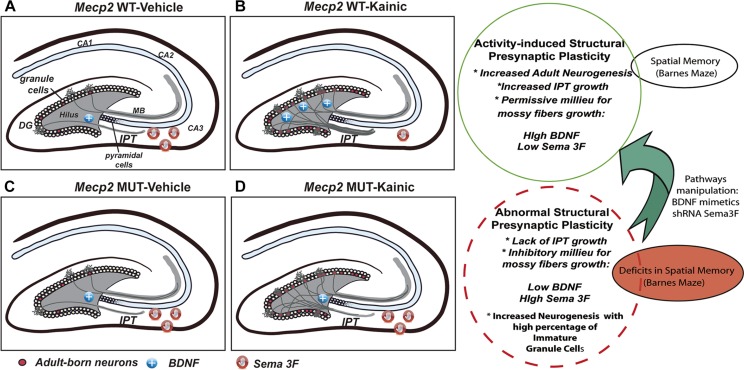
Schematic summary of the activity-induced presynaptic plasticity regulated by MeCP2. In WT mice, seizures activity increases the level of neurogenesis, accompanied with higher levels of BDNF and lower of Sema3F, allowing IPT to grow (A,B). Conversely, MUT animals show abnormal activity-dependent presynaptic plasticity characterized by the lack of IPT growth which correlates with imbalanced trophic and guidance support (BDNF and Sema3F abnormal levels). Although activity do increases the neurogenesis in MUT mice, adult born granule cells show developmental restraining and recapitulate maturational defects (C,D). These results are in line with deficits in spatial memory observed in MUT mice. This study set the basis to establish a model to evaluate the effect of manipulating specific pathways involved in axonal guidance, synaptogenesis, and neuronal maturation to correlate with changes in behavior.